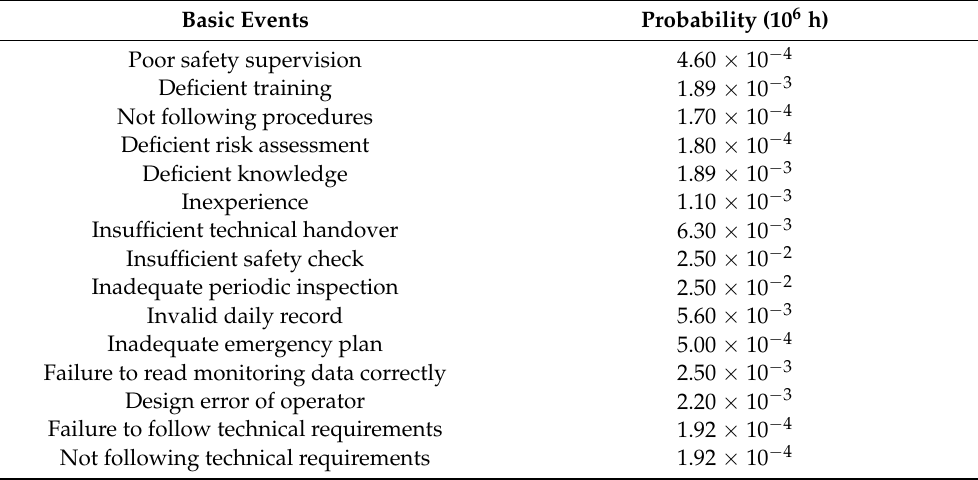
Table A1. Probability of relevant HOE basic events acquired from the